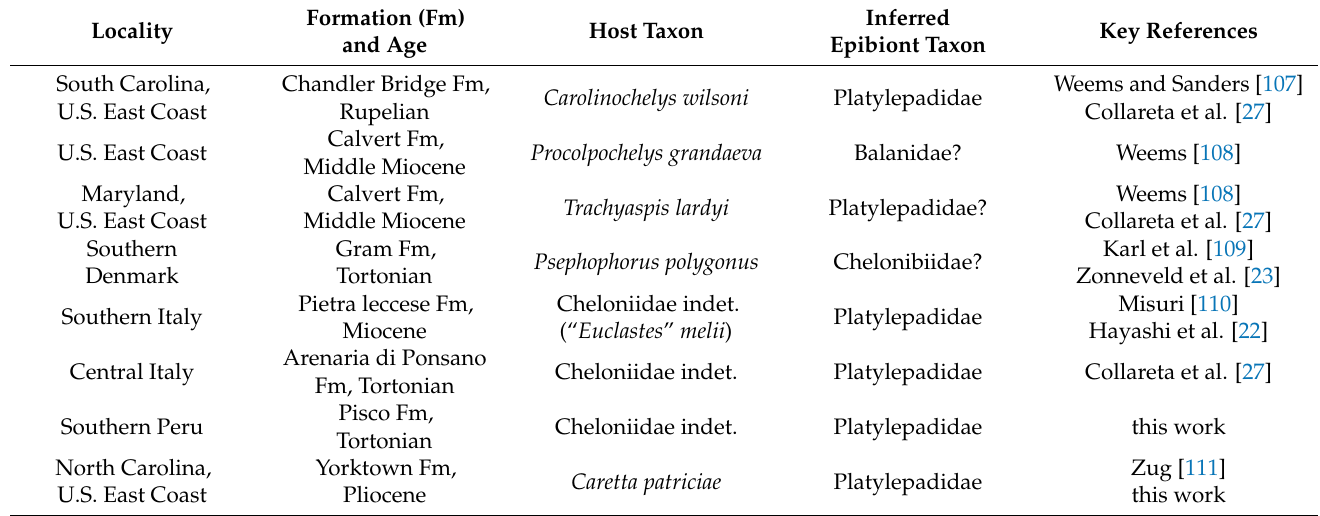
Table 1. Overview of the occurrences of bone modifications on fossil chelonians that are interpreted herein as reflecting barnacle attachment. See Section 4 for